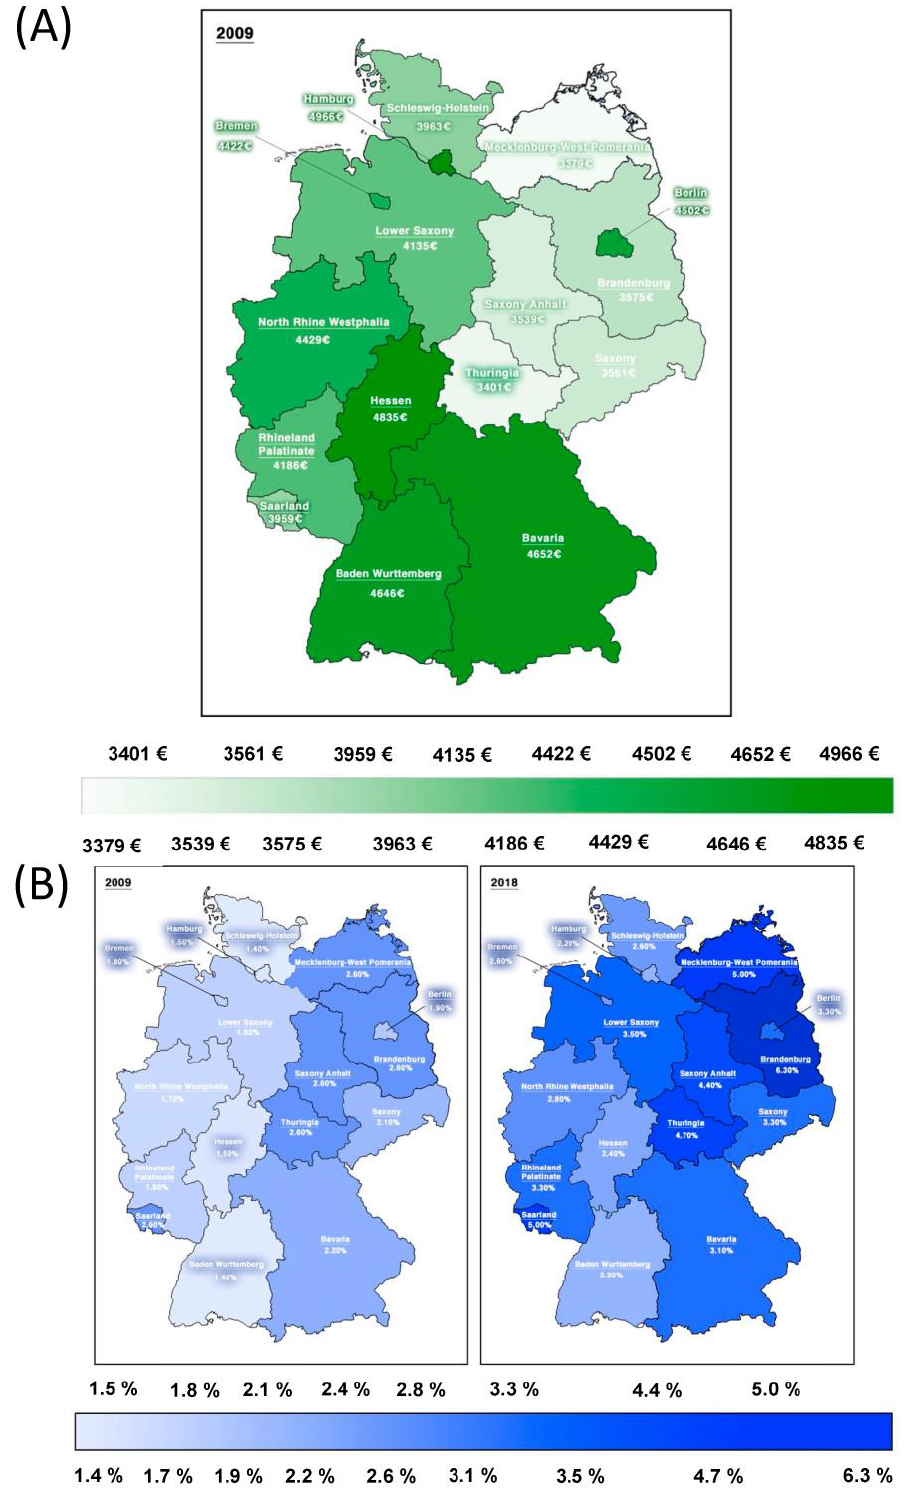
Figure 1. Stratification of German federal states according to income structure in 2009 ( A ) and prevalence of PAD 2009 vs. 2018 ( B ). For analysis of outpatient-care distribution, 17,633,970 patients with PAD were included between 2009 and 2018; 47% were living in low-income areas (average income in low-income areas EUR 3749; in high-income areas EUR 4660).